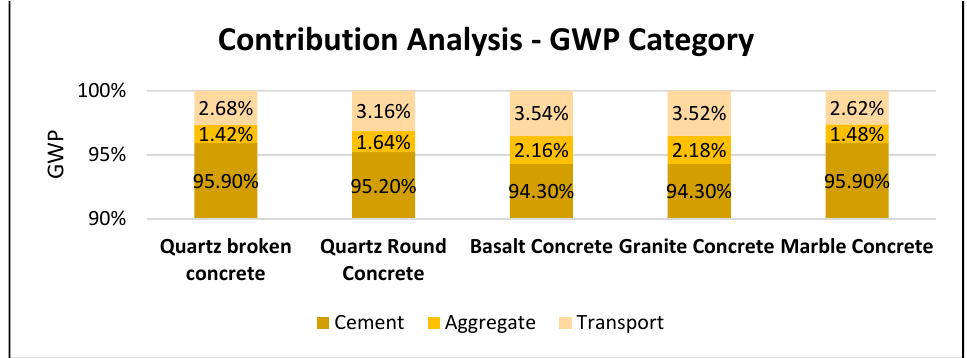
Figure 10. Global warming impact contribution analysis for primary raw material concrete samples. The study’s results highlighted the better environmental footprints across impact all the aggregates in general only had marginal differences among the impact